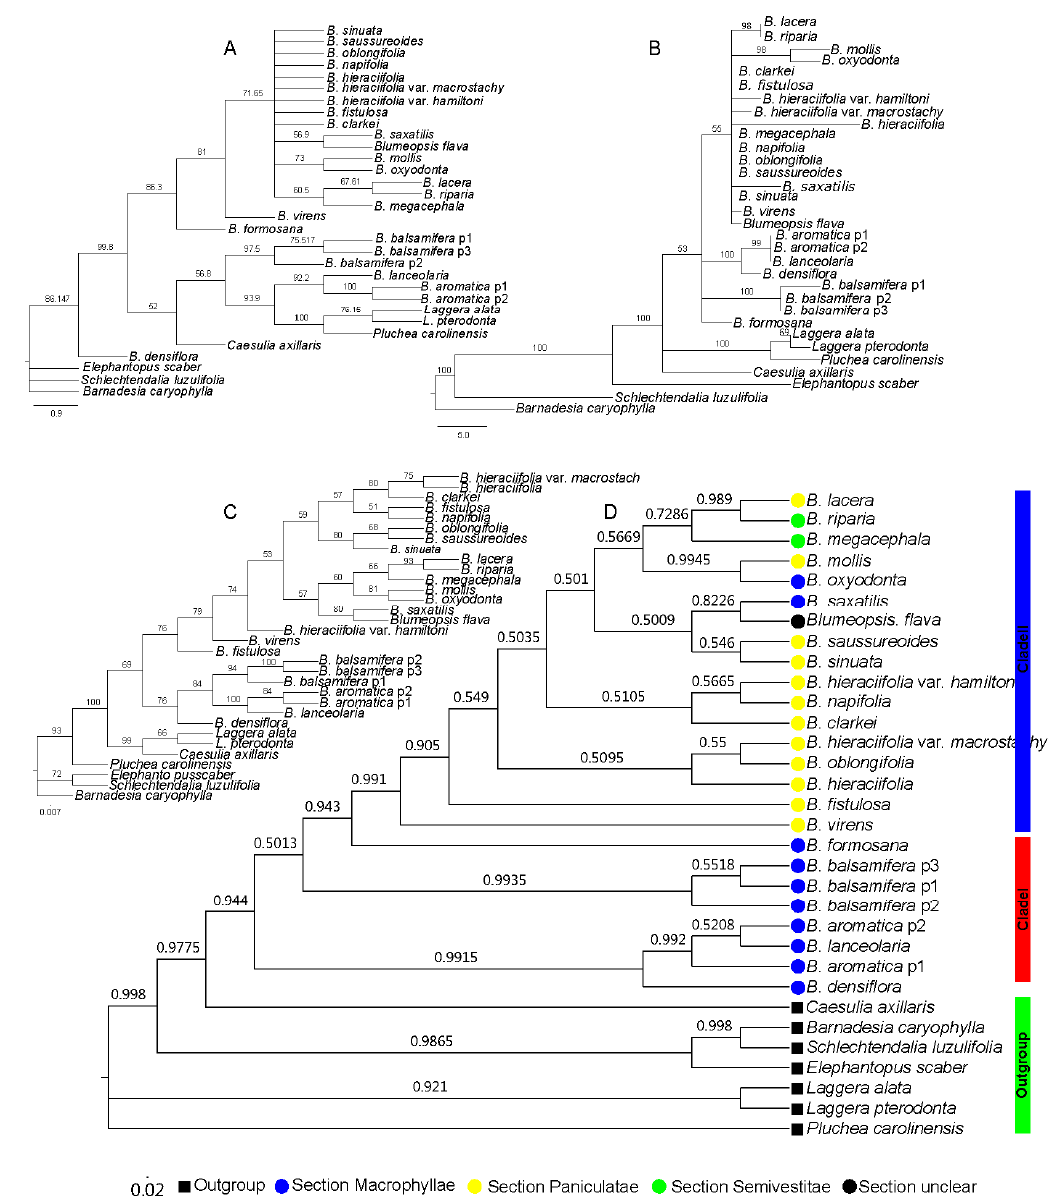
Figure 2. Phylogenetic tree based on the cpDNA trnL-F sequence, where the numbers above the branches indicate the bootstrap value or posterior probabilities. ( A ) Phylogenetic tree determined by the NJ method using the PAUP program; the numbers above the branches indicate the bootstrap value. ( B ) Phylogenetic tree with best topology, determined by the MP method using the PAUP program; the numbers above the branches indicate the bootstrap value. ( C ) Phylogenetic tree determined by the ML method using the IQtree program; the numbers above the branches indicate the bootstrap value. ( D ) Phylogenetic tree determined by the BI method with using the MrBayes program; the numbers above the branches indicate the posterior probabilities.